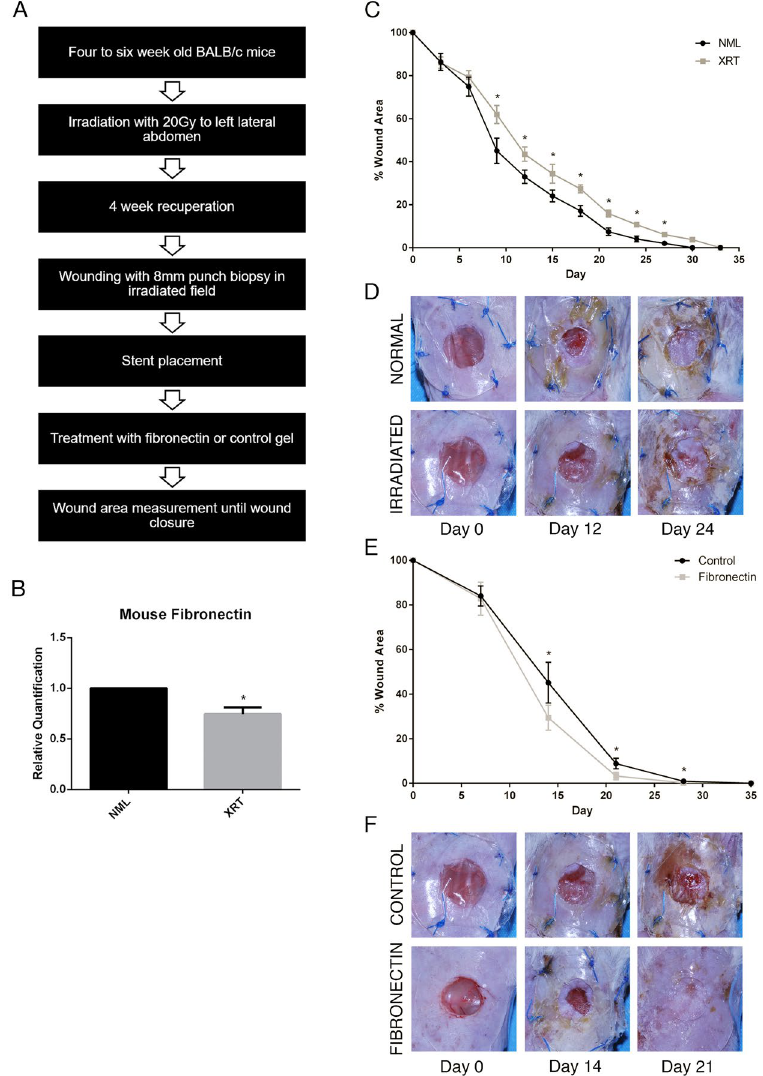
Figure 3. ( A ) Flow diagram for experimental methodology. ( B ) qRT-PCR demonstrating that fibronectin expression is significantly downregulated after radiation of mouse skin 4–6 weeks after exposure. ( C ) Irradiated skin heals significantly slower than normal skin at all time points (p < 0.05). ( D ) Representative normal (top) and irradiated (bottom) wounds at days 0, 12, and 24 post-wounding. ( E ) Topical application of fibronectin at the time of wounding is associated with significantly accelerated wound healing at all time points (p < 0.05). ( F ) Representative radiated wounds with vehicle control (top) and fibronectin treatment (bottom) at days 0, 14, and